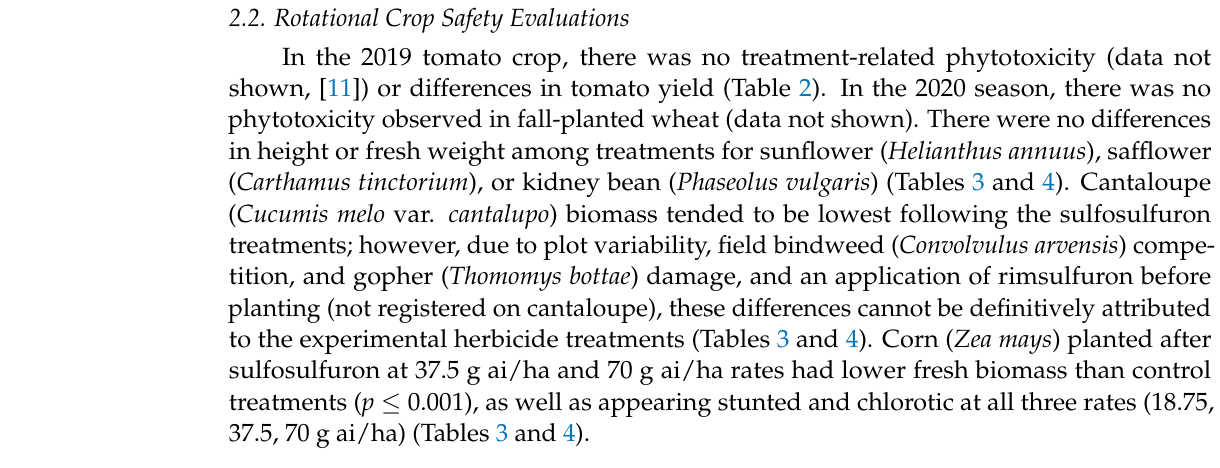
Table 2. Effects of herbicide treatments on a 2019 processing tomato yield as a part of a rotational crop study conducted in Yolo County, CA,